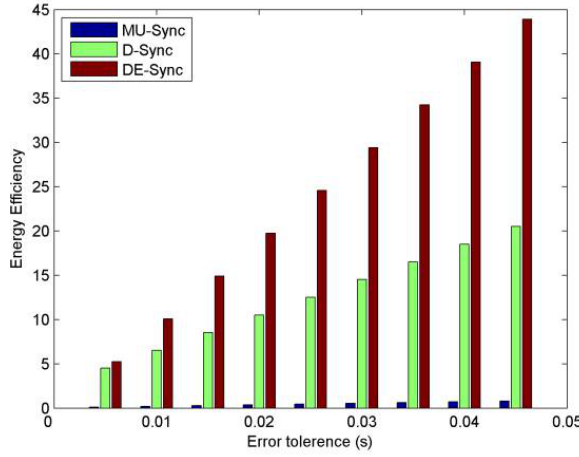
Figure 10. Energy efficiency vs error tolerance.